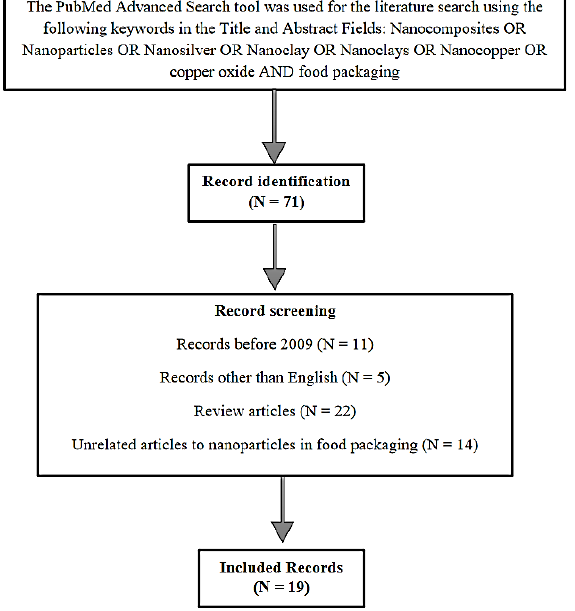
Figure 1. Flowchart for the selection process of the included articles.